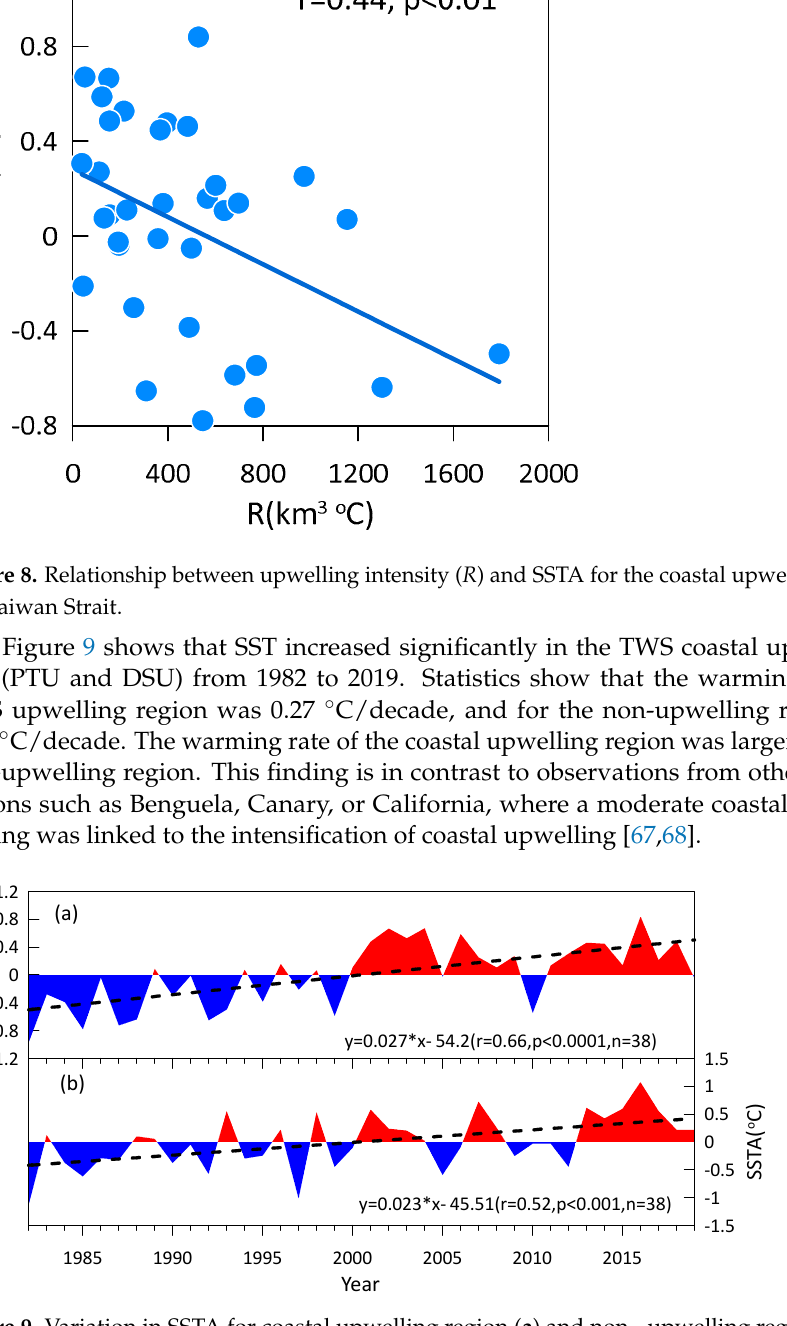
Figure 9. Variation in SSTA for coastal upwelling region ( a ) and non − upwelling region ( b ) during 1982–2019.